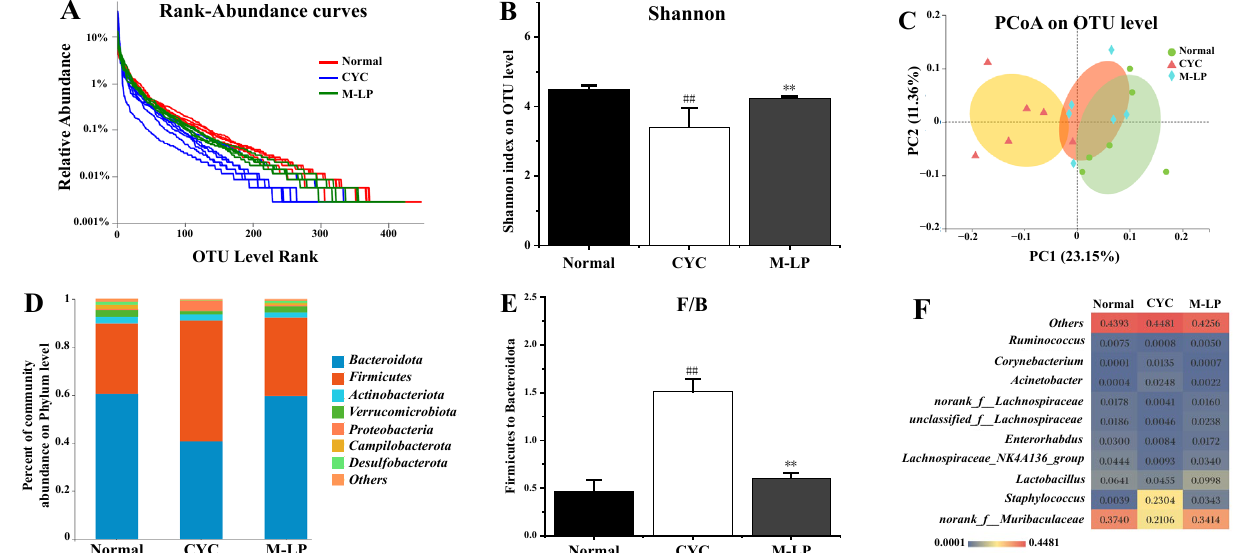
Figure 5. Effect of LP on CYC-induced intestinal microbiota imbalance in mice. ( A ) Rank-abundance curves; ( B ) Shannon index; ( C ) PCoA analysis; ( D ) Analysis of intestinal microbiota structure at phylum level; ( E ) F/B ratio; ( F ) Analysis of differential intestinal microbiota at genus level. Note: n = 6, ## p < 0.01 vs. Normal group, ** p < 0.01 vs. CYC group.